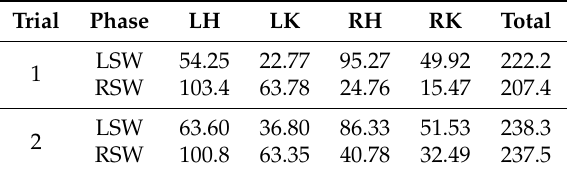
Table 3. RMS joint torque of walking motion (Nm) Trial